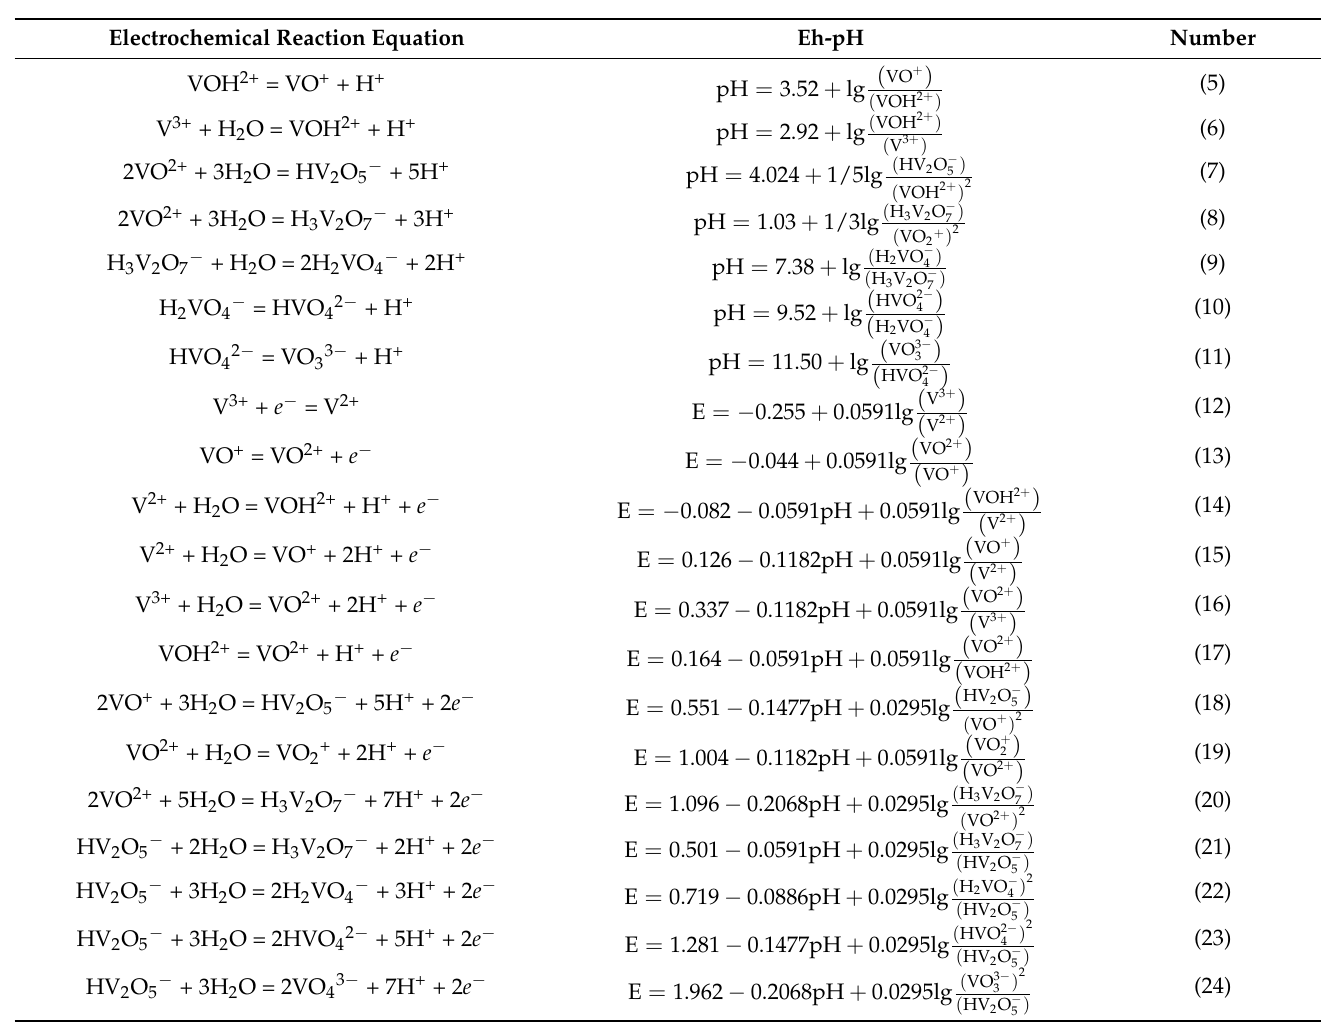
Table 1. Main electrochemical reaction equations of V-H 2 O